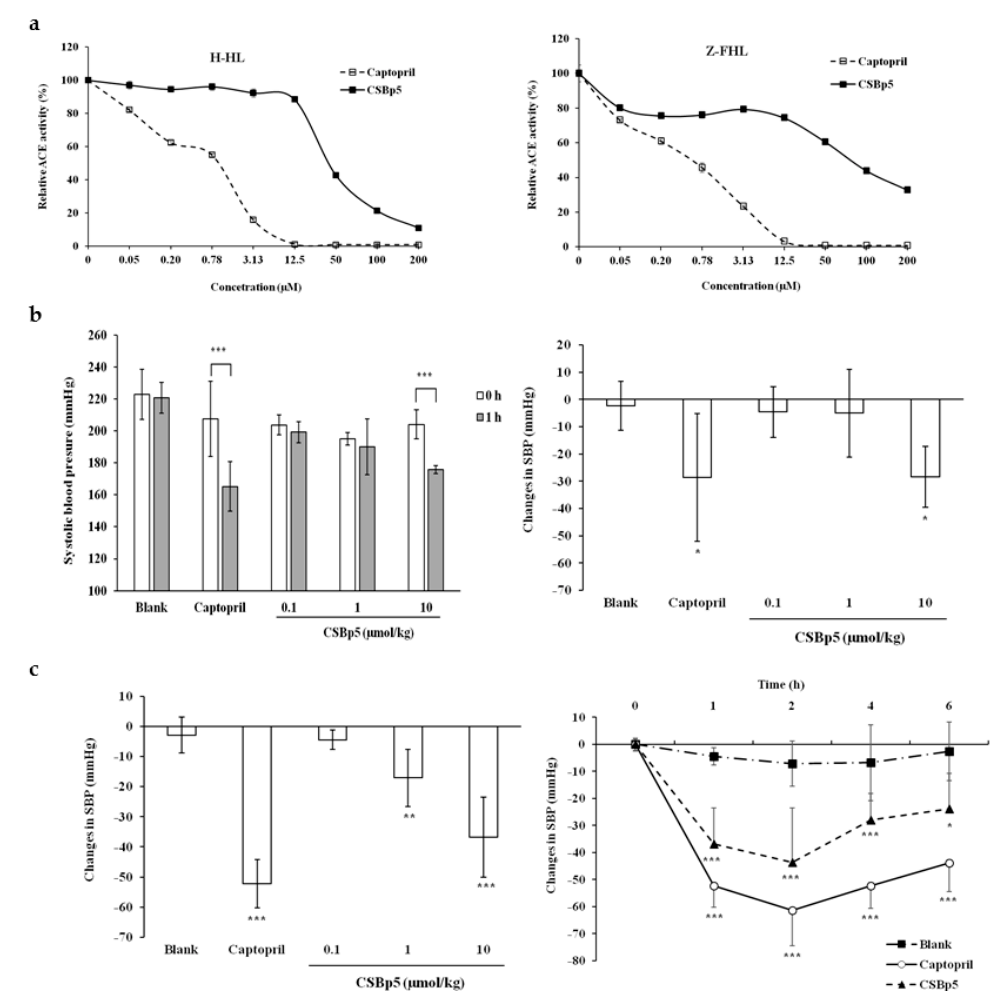
Figure 3. Effects of CSBp5 on ACE activity and blood pressure. ( a ) ACE activity assay. Various